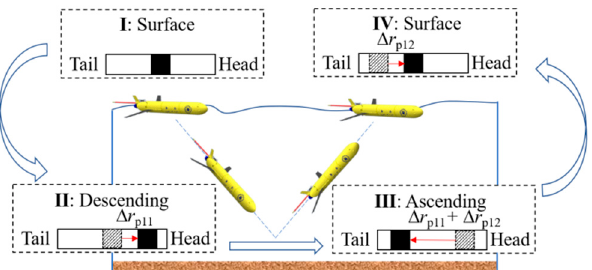
Figure 4. Schematic for the route of the moving internal point mass in one work cycle (In practice, the moving direction of the moving internal point mass may be opposite to that in the figure due to the torque imposed by the buoyancy engine) .